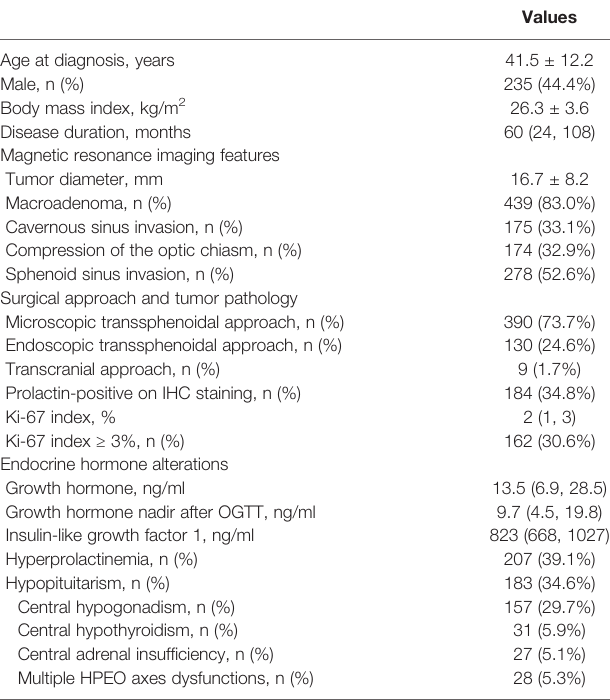
TABLE 1 | Clinical and endocrine features of 529 active acromegaly